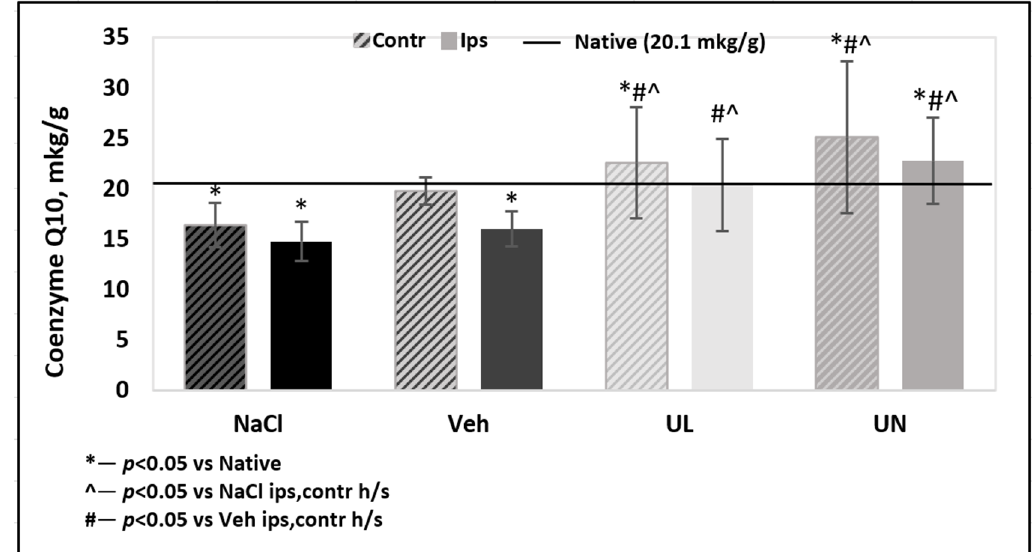
Figure 5. Coenzyme Q10 brain level measured by HPLC 24 hours after middle cerebral artery occlusion. Groups: NaCL–MCAO + NaCL; Veh–MCAO + Vehicle; UL–MCAO + Ubiquinol; UN–MCAO + Ubiquinone. Contr—contrlatheral hemisphere; Ips—ipsilatheral hemisphere. Baseline—CoQ10 level in native group.